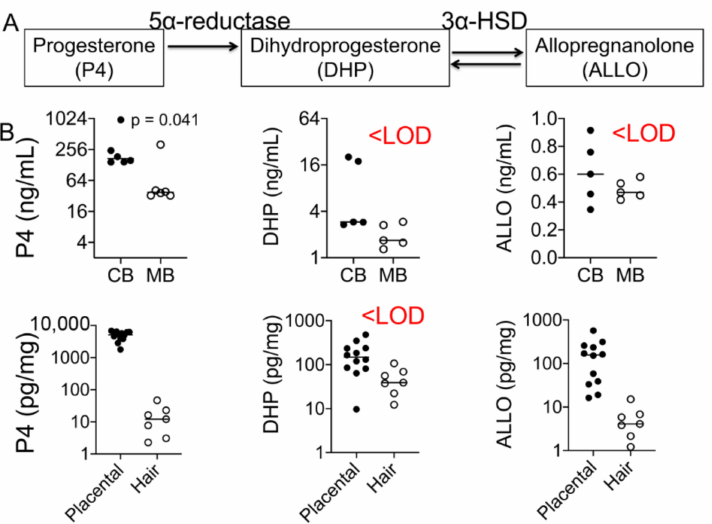
Figure 3. Progesterone and its metabolites’ levels in maternal and fetal samples. ( A ) Graphic illustration of the relationship between progesterone and its metabolites, dihydroprogesterone (DHP) and allopregnanolone (ALLO). Progesterone is converted to DHP by the action of the enzyme 5 α - reductase. DHP is converted to the second metabolite ALLO by 3 α -HSD. ( B ) Cord progesterone levels were ~3-fold higher than maternal plasma progesterone levels ( p = 0.041; n = 6). Placental progesterone levels were several-fold greater than maternal hair progesterone levels ( p < 0.0001). DHP levels were below the level of detection (LOD) in both maternal and fetal samples, whereas ALLO was only detected in placental tissues ( n = 17). Mann–Whitney U test and Spearman’s correlation analysis.